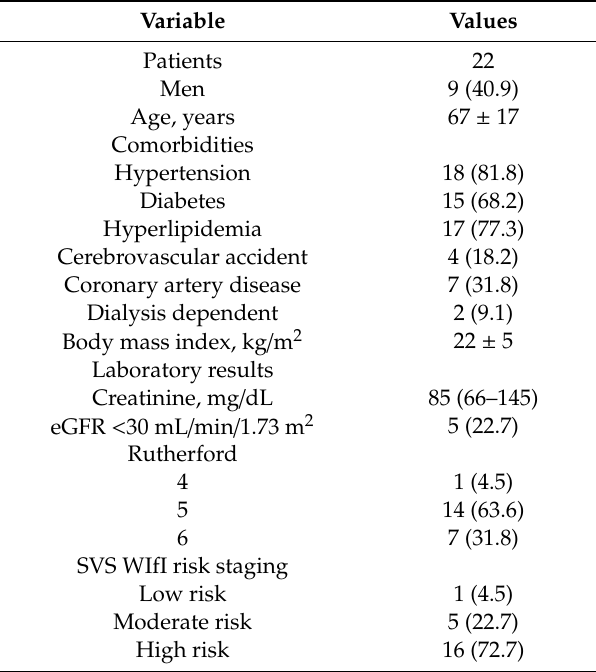
Table 1. Baseline